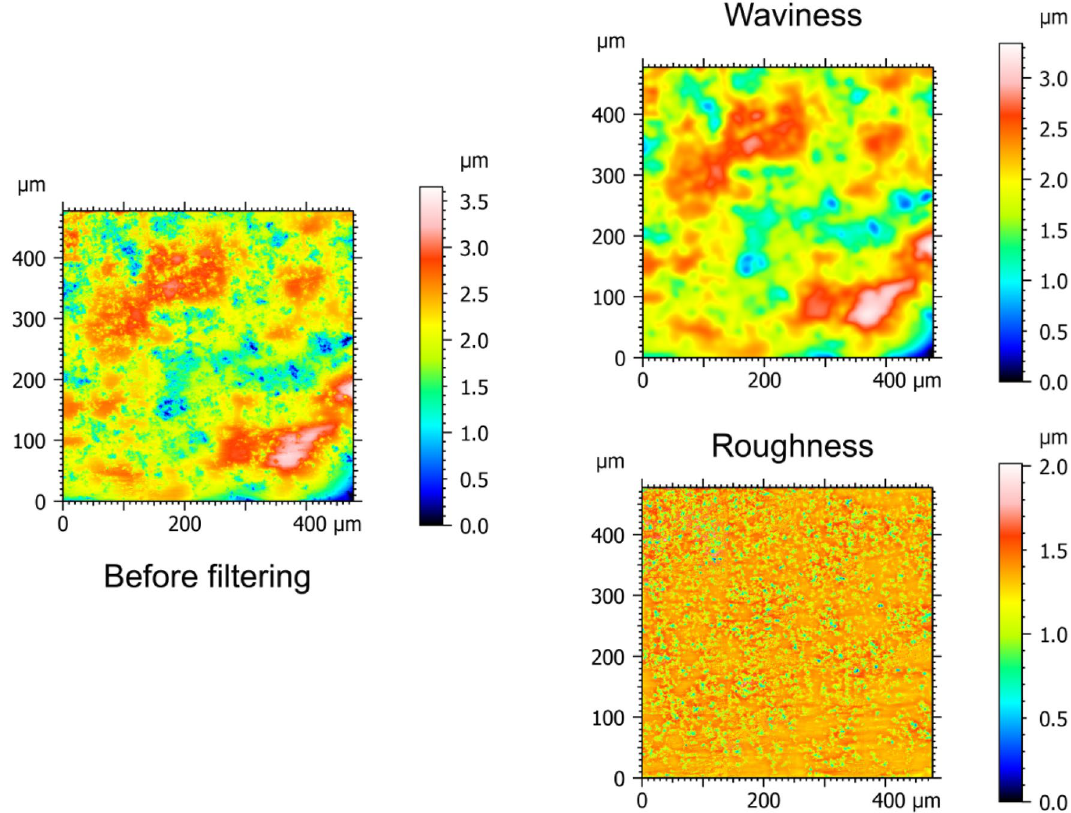
Figure 3. Example of filtering with Zone 12 (left) before filtering and (right) after filtering with a cut-off length of 25 µm: as a high-pass filter is used, only the roughness part is kept for the